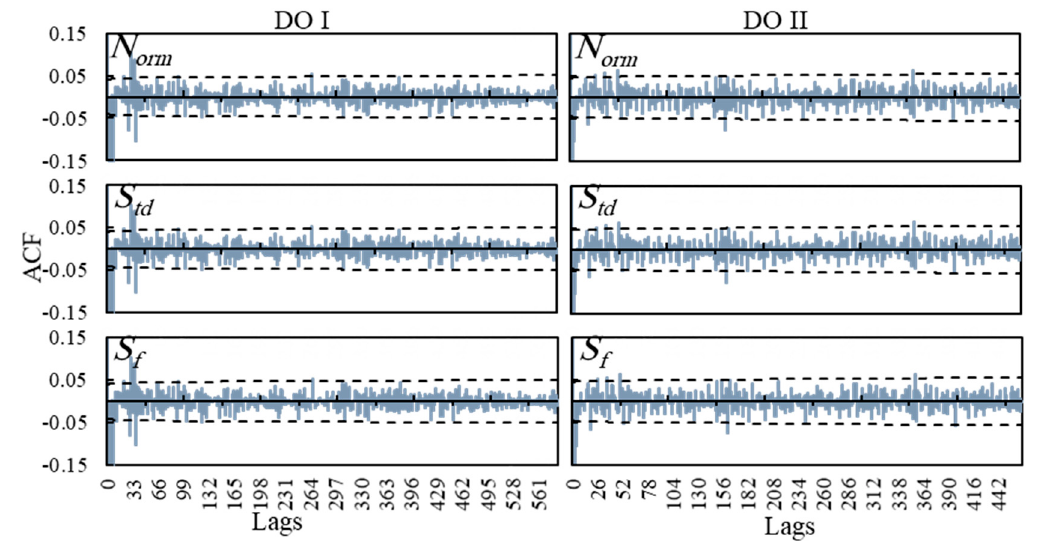
Figure 5. Autocorrelation function plot of DO data (ARIMA first-order differencing operator) at both DO stations I and II.